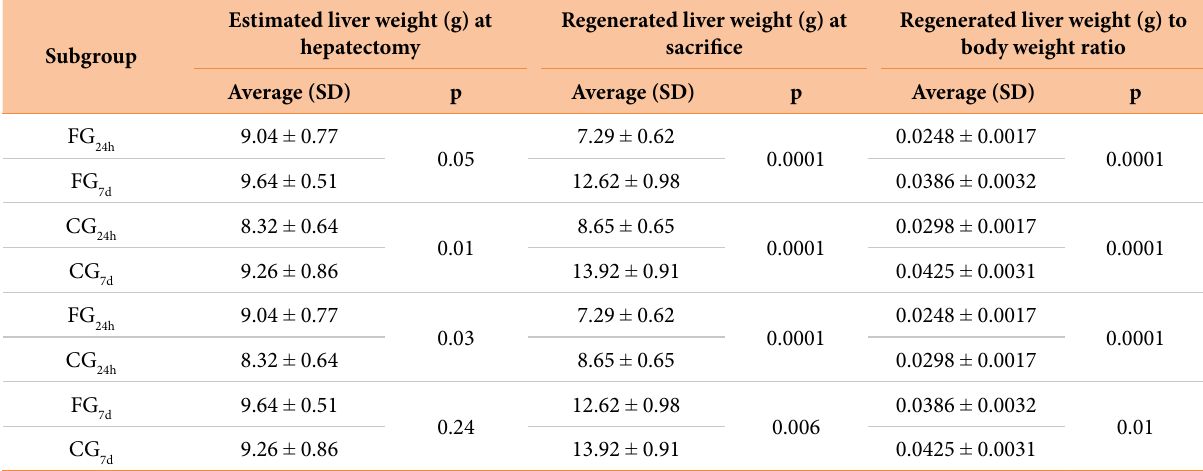
Table 2 - Intragroup (24 h vs. 7 days) and intergroup (control vs. fluorouracil) comparisons of liver weight (g) at hepatectomy and sacrifice days and regenerated liver to the body weight